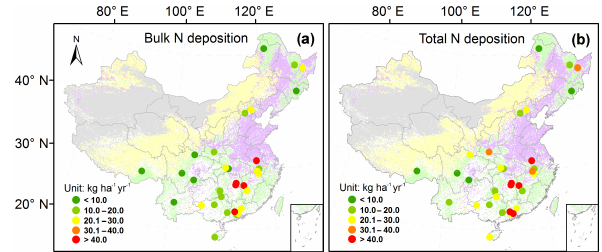
Figure 2. Spatial patterns of (a) bulk N deposition (kgha − 1 yr − 1 ) and (b) total N deposition (kgha − 1 yr − 1 ) in China’s forests. The background shading in light green, light yellow, light purple and light grey indicates the distribution of forest, grassland (semiarid region), cropland and non-vegetated land, respectively.